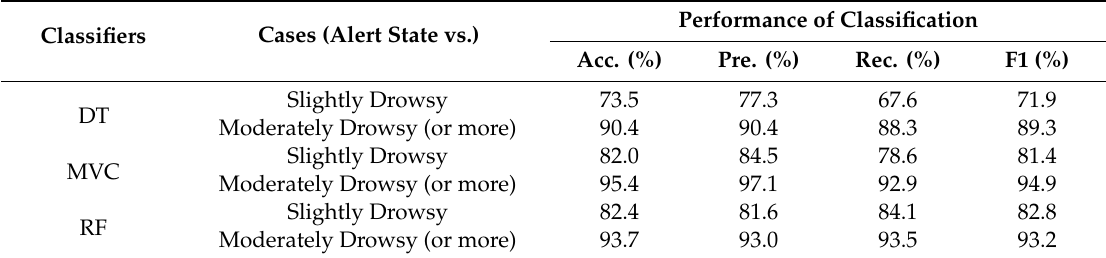
Table 3. Classification results in the case of using full hybrid